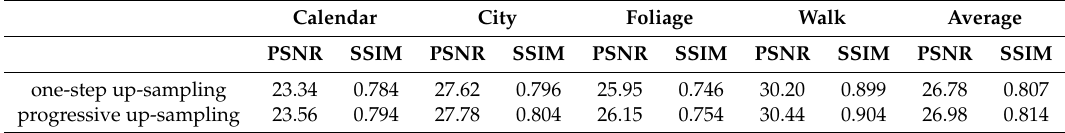
Table 7. The influence of the progressive up-sampling mechanism for 4 × VSR.